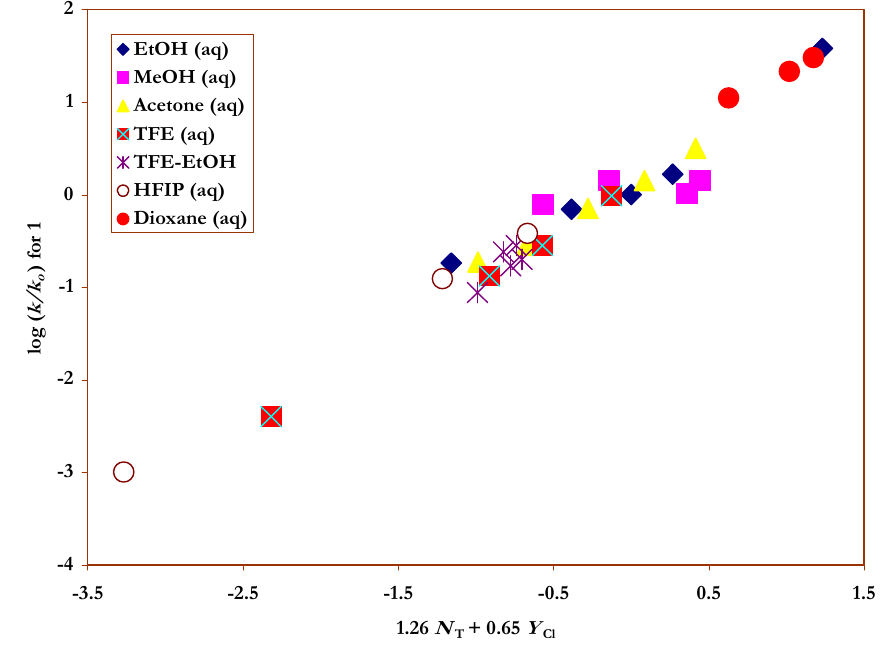
Figure 2. The plot of log ( k/k sulfonyl chloride ( 1) in pure and binary solvents at 35.0